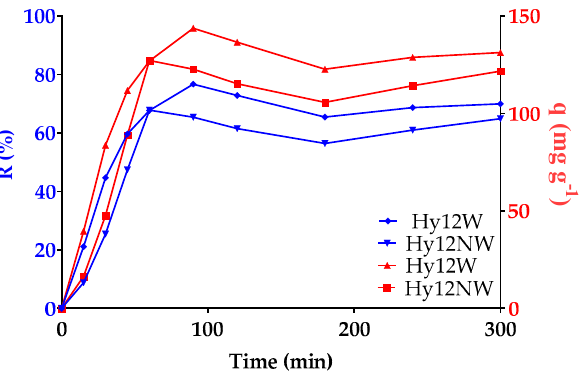
Figure 6. Dye retention and capacity of adsorption per gram of resin by hydrogel, as a function of time for Hy12NW and Hy12W at pH 7.64.